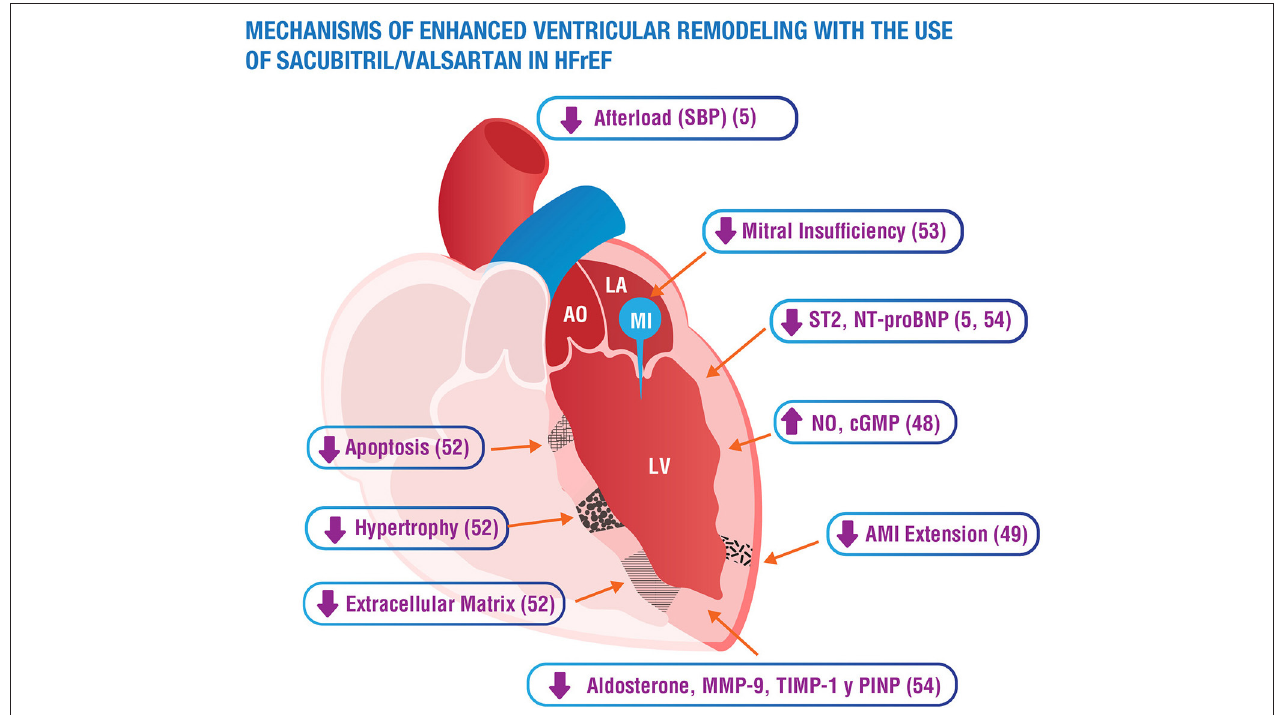
FIGURE 3 | Summary of mechanisms of sacubitril/valsartan enhancement of ventricular remodeling. AO, aorta; LA, left atrium; LV, left ventricle; MI, mitral insufficiency; cGMP, cyclic guanosine monophosphate; NO, nitric oxide; sST2, soluble suppression of tumorigenesis-2; Nt-proBNP, N-terminal pro-brain natriuretic peptide; SBP, systolic blood pressure; AMI, acute myocardial infarction; MMP-9, matrix metallopeptidase 9; TIMP-1, tissue inhibitor of metalloproteinase-1; PINP, aminoterminal propeptide of type I